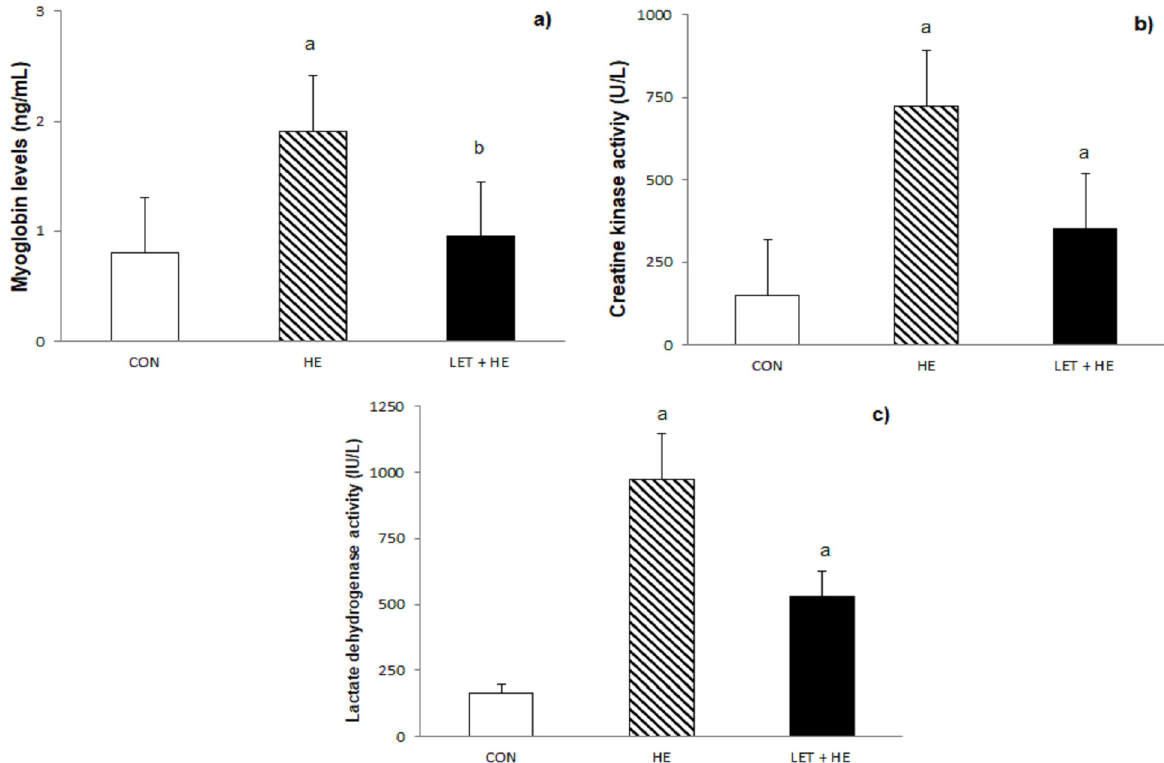
CON: Control group, HE: High-intensity eccentric exercise group, LET + HE: Low-intensity eccentric exercise training plus high-intensity eccentric exercise